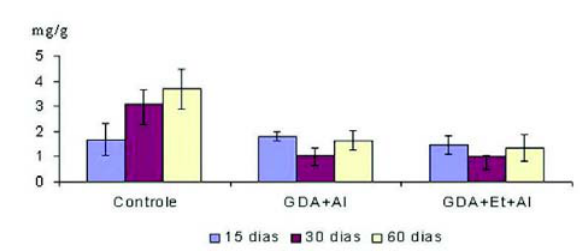
Fig. 7- Análise pela espectroscopia de absorção atômica da presença de calcificação, nos três grupos estudados, ao longo do